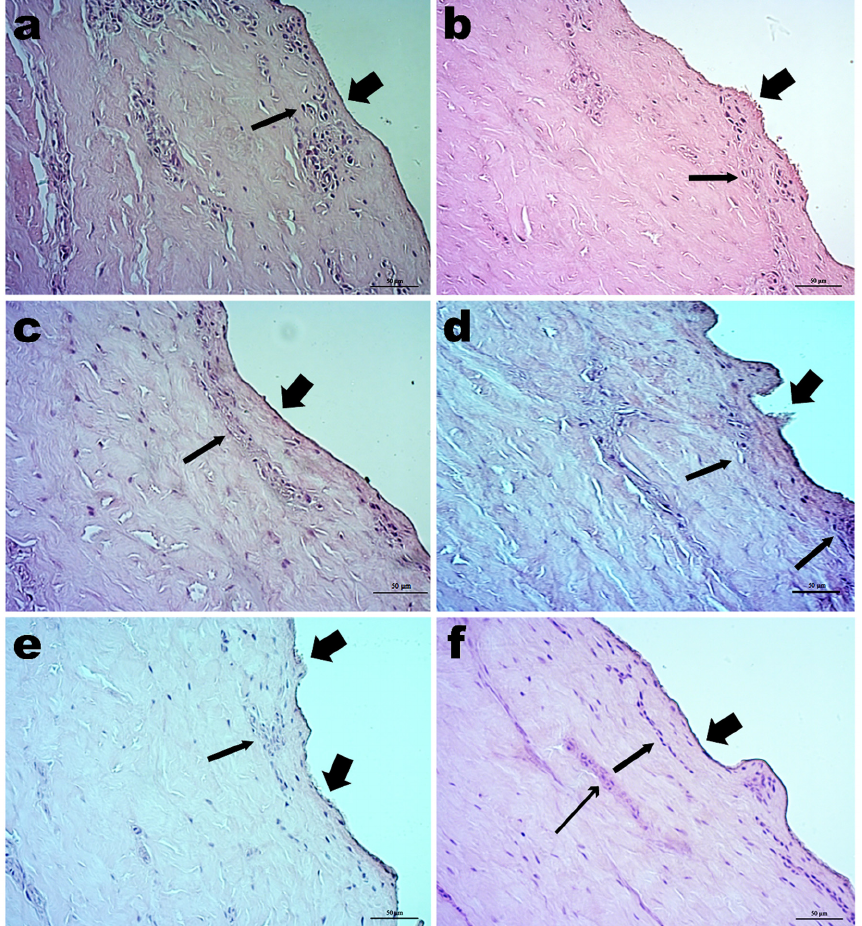
Figure 3. Photomicrographs (×200 magnification) of ( a ) the histological sections of plain porcine ear skin, and of porcine ear skin following contact with ( b ) 0.5% CG-DES, ( c ) 1.0% CG-DES, ( d ) 1.5% CG-DES, ( e ) 2.0% CG-DES, and ( f ) 2.5% CG-DES. All sections were stained with hematoxylin and eosin. For the legend of inserted (thick, thin, and skinny) arrows, please refer to the Discussion section.